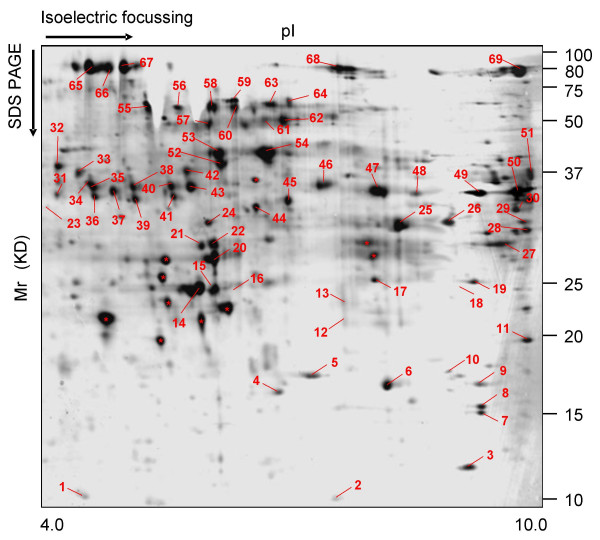
Protein identifications from a representative xylem sap 2-DE gel. Representative 2-DE gel of xylem sap proteins from 12-week-old Brassica napus plants. Proteins were identified by partial sequences determined by tandem mass spectrometry. Numbers indicate spots from which proteins could be identified. Sequences and identifications are listed in Table 1. Asterisks indicate spots that were analyzed but led to no or low quality mass spectra that did not allow protein identifications. Molecular masses in kD are indicated on the right hand side of the gel.